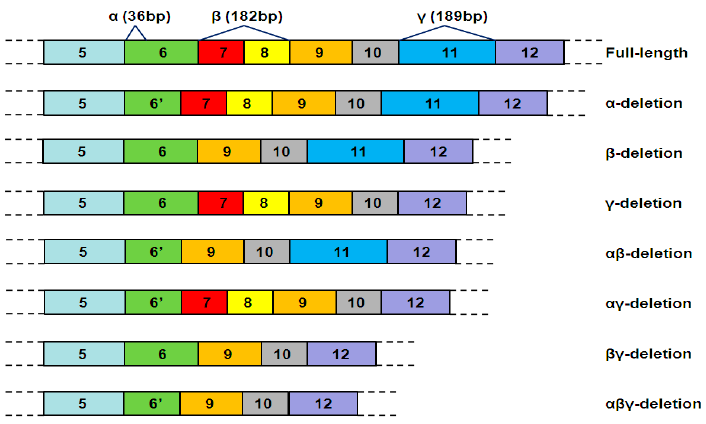
Figure 1. The three deletion sites of human telomerase transcriptase (hTERT) pre-mRNA alternative splicing ( α , β , γ ). There are seven alternative splicing variants (ASVs) of hTERT, and they are the α -deletion, β -deletion, γ -deletion, αβ -deletion, αγ -deletion, βγ -deletion, and αβγ -deletion ASV. The numbers from 5 to 12 indicate exon 5 to exon 12.